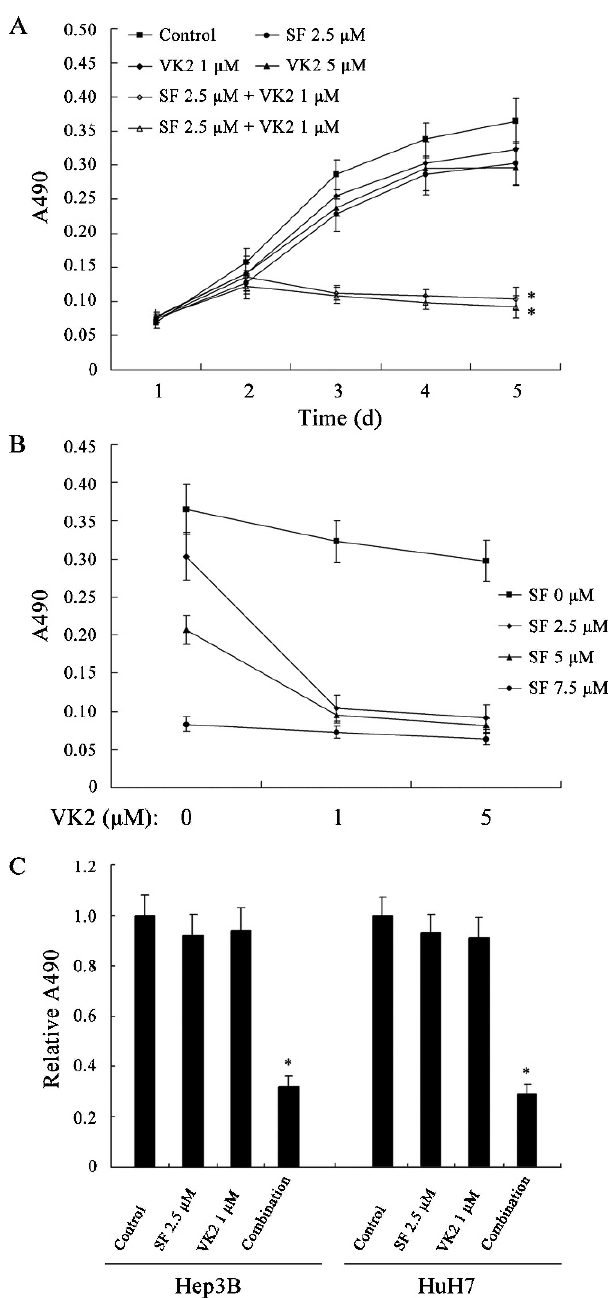
Figure 1 - Combined treatment with sorafenib and VK2 inhibits HCC cell growth. (A) Growth inhibition of HepG2 cells by sorafenib, VK2 or the two in combination. (B) The growth- inhibitory effects of VK2 in addition to various sorafenib concentrations. (C) Growth inhibition of Hep3B and HuH7 cells by sorafenib, VK2 or the two in combination. SF: sorafenib. Each point represents the mean ¡ SD of three independent experi- ments. * p , 0.05 vs. control or